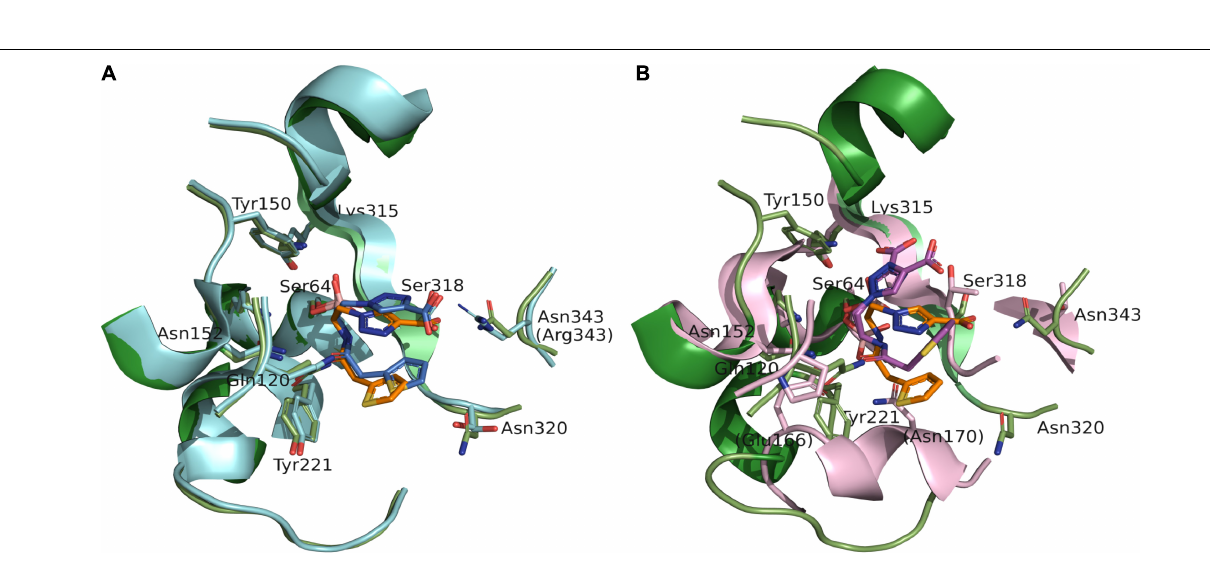
Frontiers in Microbiology |